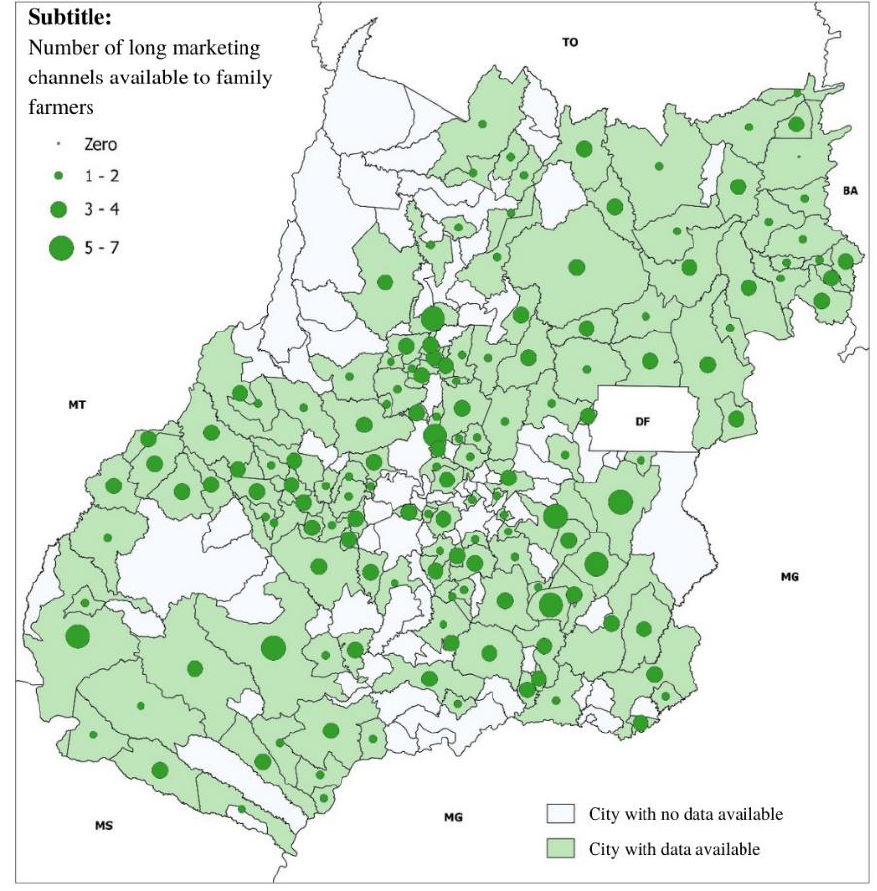
Figure 1. Map of the number of long marketing channels available to family farmers in Goiás. The average number of long marketing channels available to family farmers, and an av- erage number of marketing posts of the long channel-type available to family farmers, was low compared to the average number of rural family establishments in the sampled municipalities (Table 1). Table 1. Mean, standard deviation, and standard error of the quantities of long canals, commercial- ization posts, and rural family establishments in the sampled municipalities.